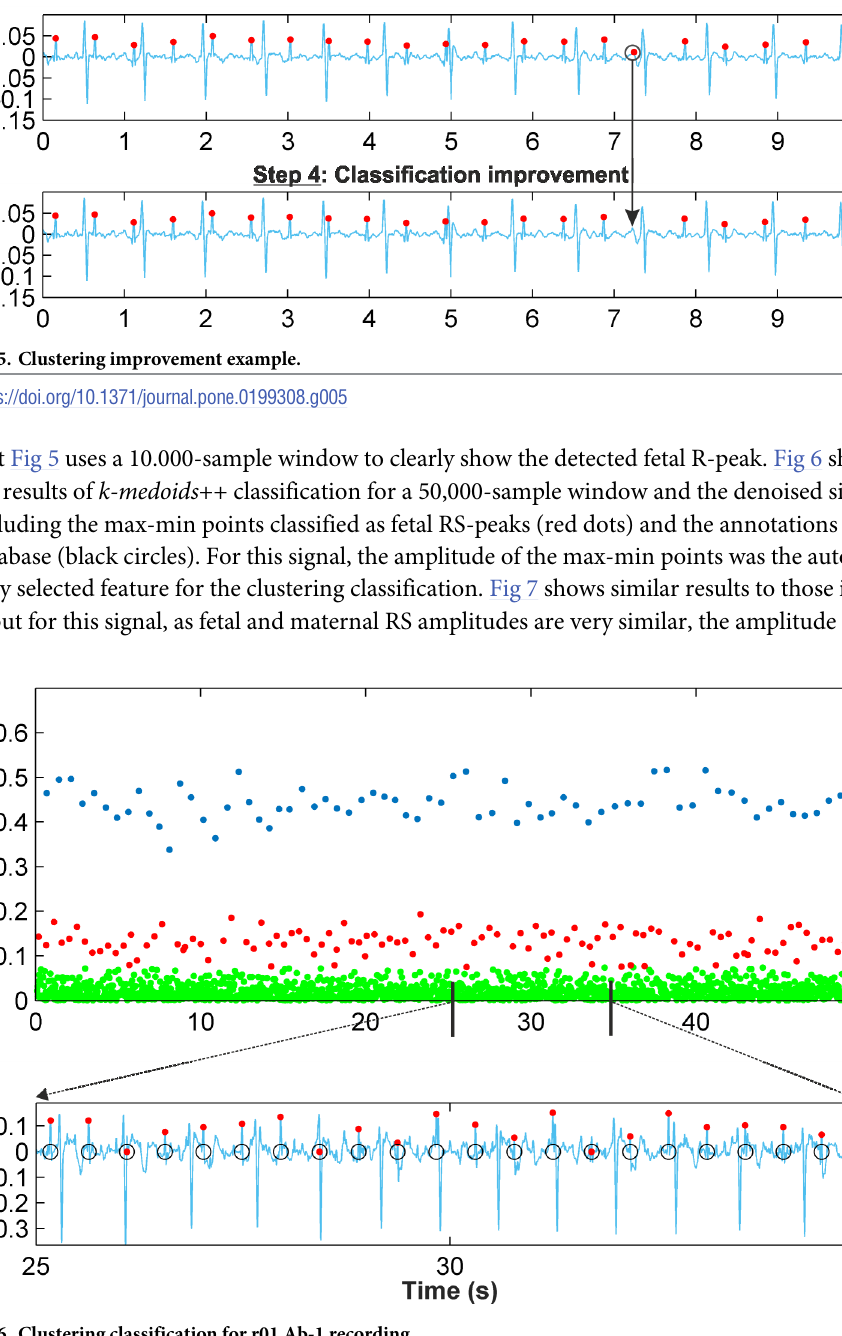
Fig 6. Clustering classification for r01 Ab-1